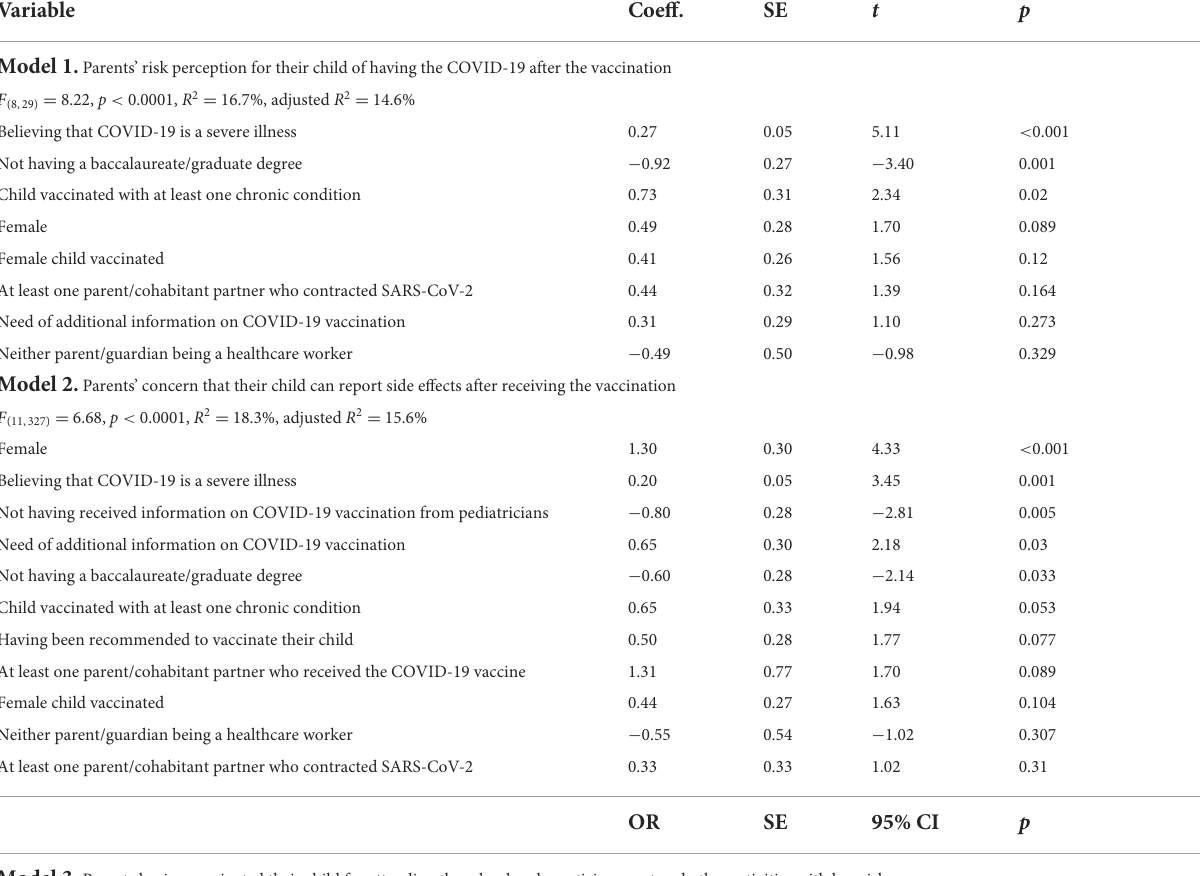
TABLE 2 Determinants of the different outcomes of interest using linear and logistic regression analysis. Variable Coeff. SE t